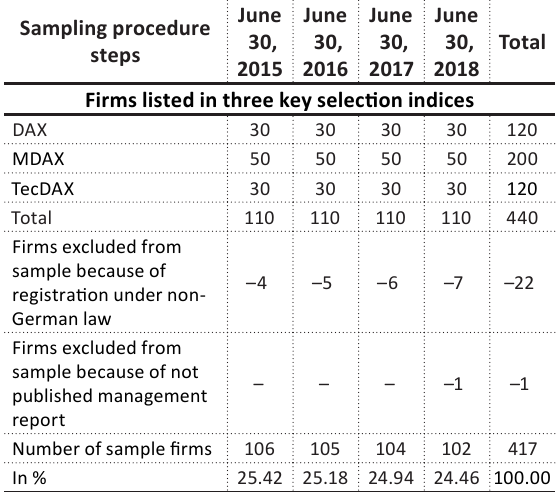
Table 1. Sample selection